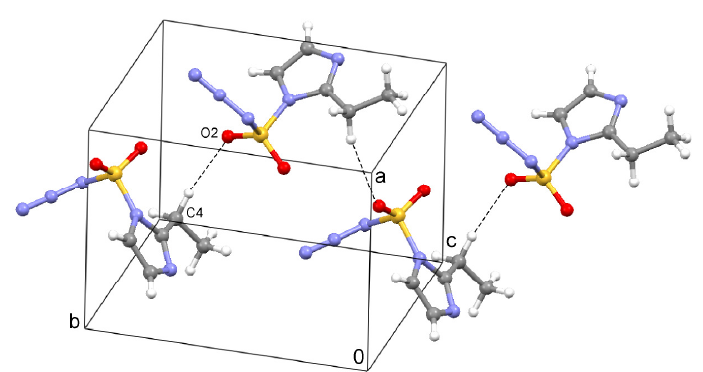
Figure 2. The molecules of 1 are arranged into chains by short C–H...O contacts in the direction of the crystallographic b